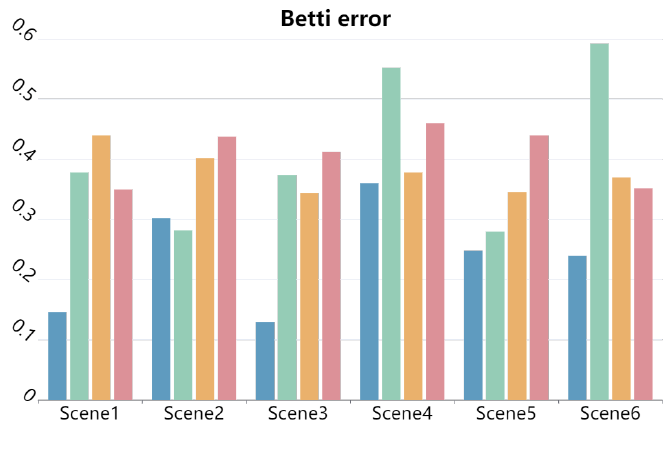
Figure 7. Quantitative comparison of our method with FloorNet and Floor-SP in terms of Betti error. The figures are represented by increasing numbers. Our* is the non-Manhattan result of our method.